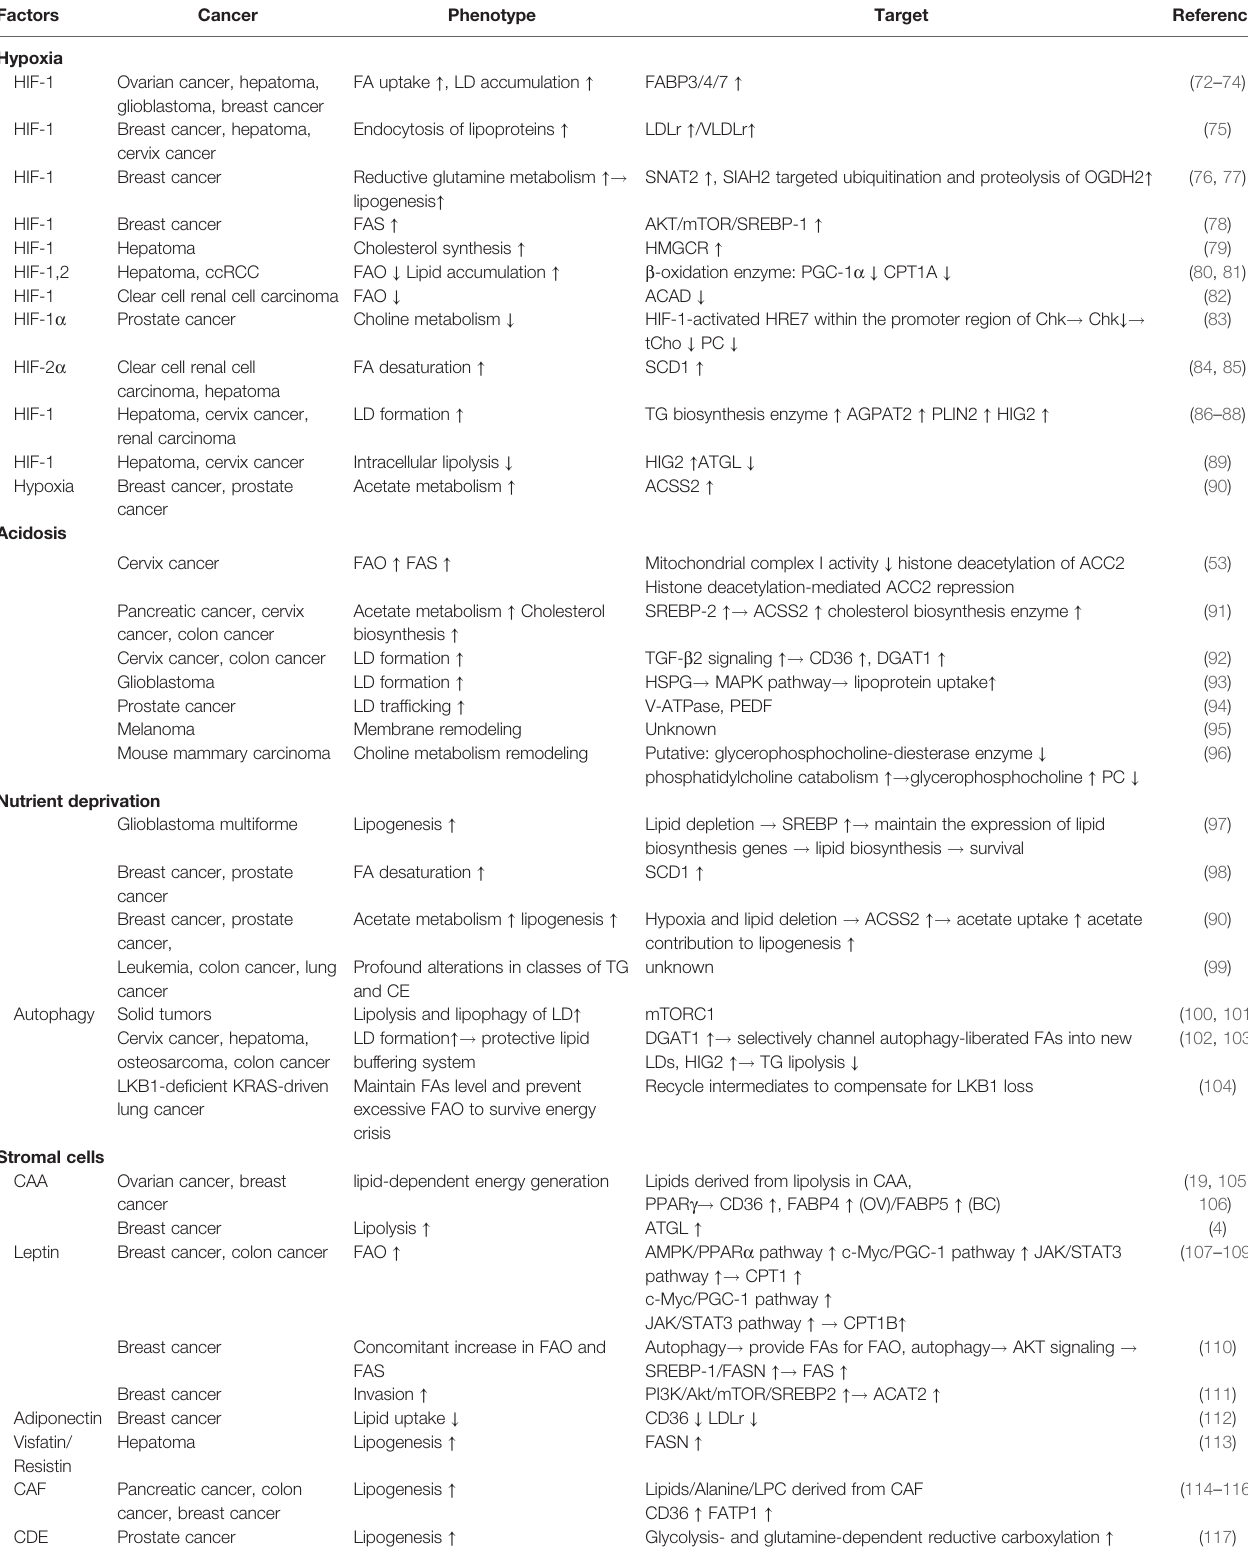
TABLE 1 | Non-exhausted list of microenvironmental factors regulating tumor lipid